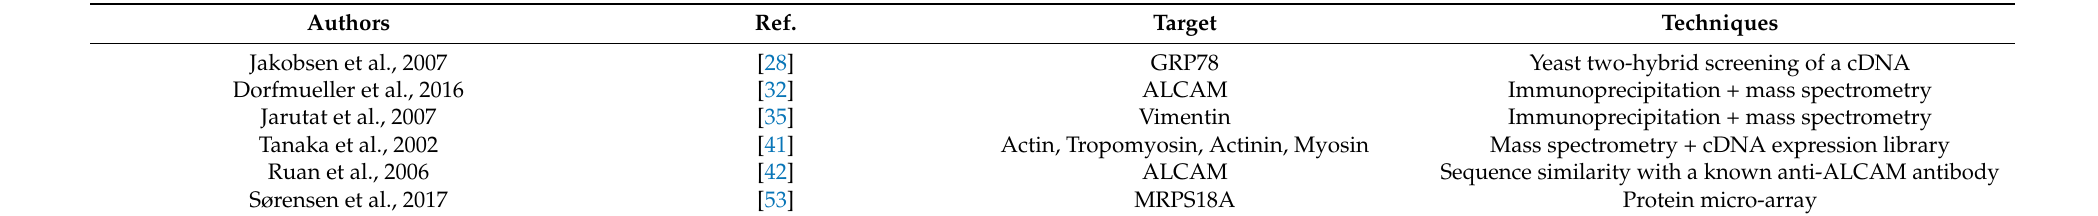
Table 2. Antibody target